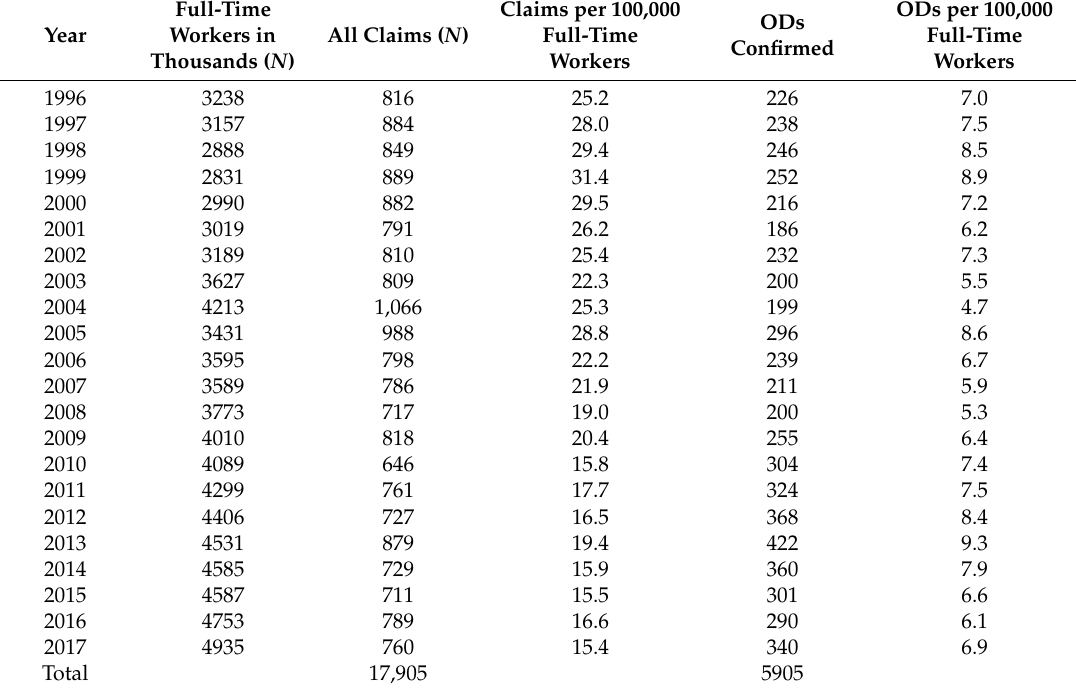
Table 1. Claims and confirmed occupational diseases (ODs) from 1996 to